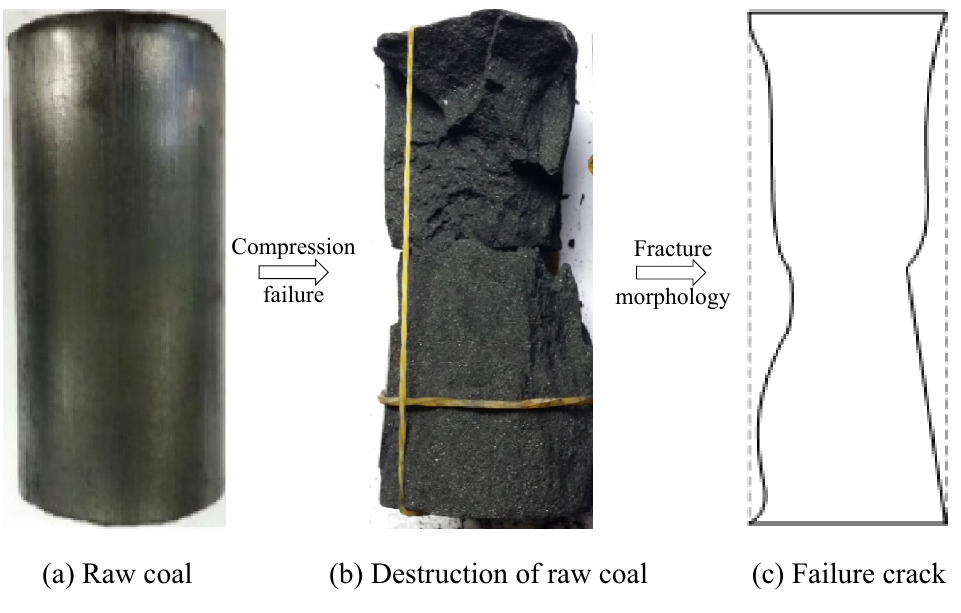
Figure 5. The failure forms of sample X2 under uniaxial compression.